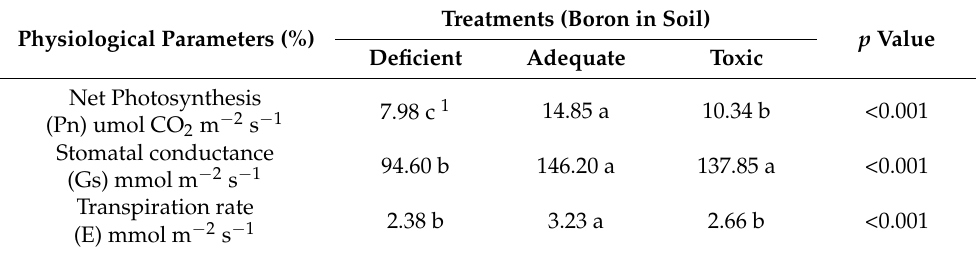
Table 3. Effect of three concentrations of soil boron availability, deficient, adequate, and toxic (0.04,